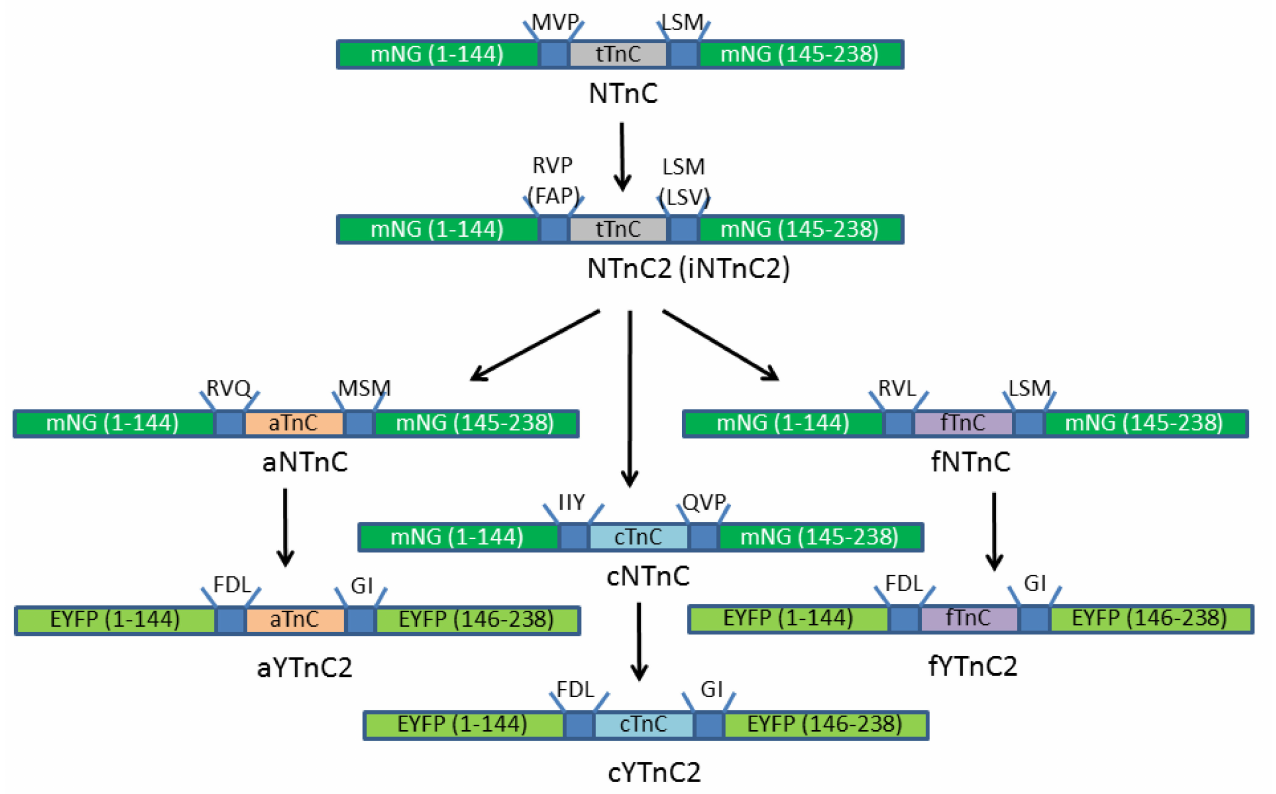
Figure 2. Scheme of engineering NTnC-like indicators. Table 1. Properties of NTnC2 and iNTnC2 in vitro and in neuronal cultures. a Determined at 300